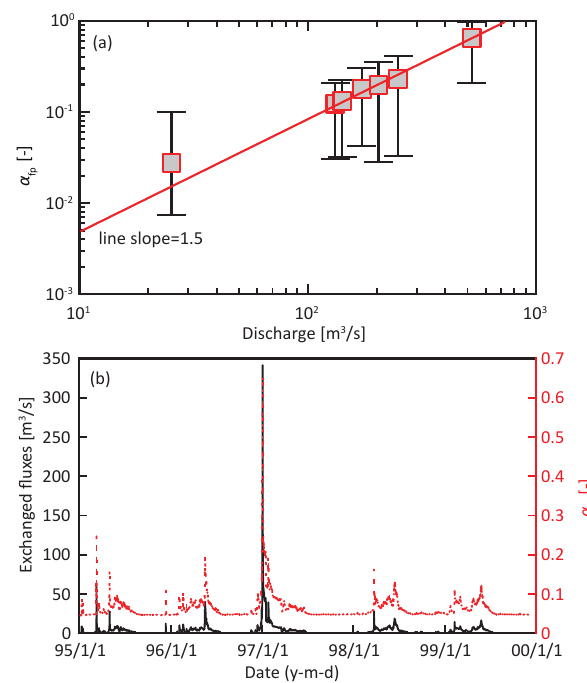
Figure 8. (a) The proportion of total flow that routed through the floodplains ( α fp ) versus inflow discharge. The function of the fitted line is y = 5 . 0 e − 5 x 1 . 5 ( R 2 = 0.984). (b) The mean value of α fp for McCarran Ranch from year 1995 to 2000 based on applying the former function in (a)